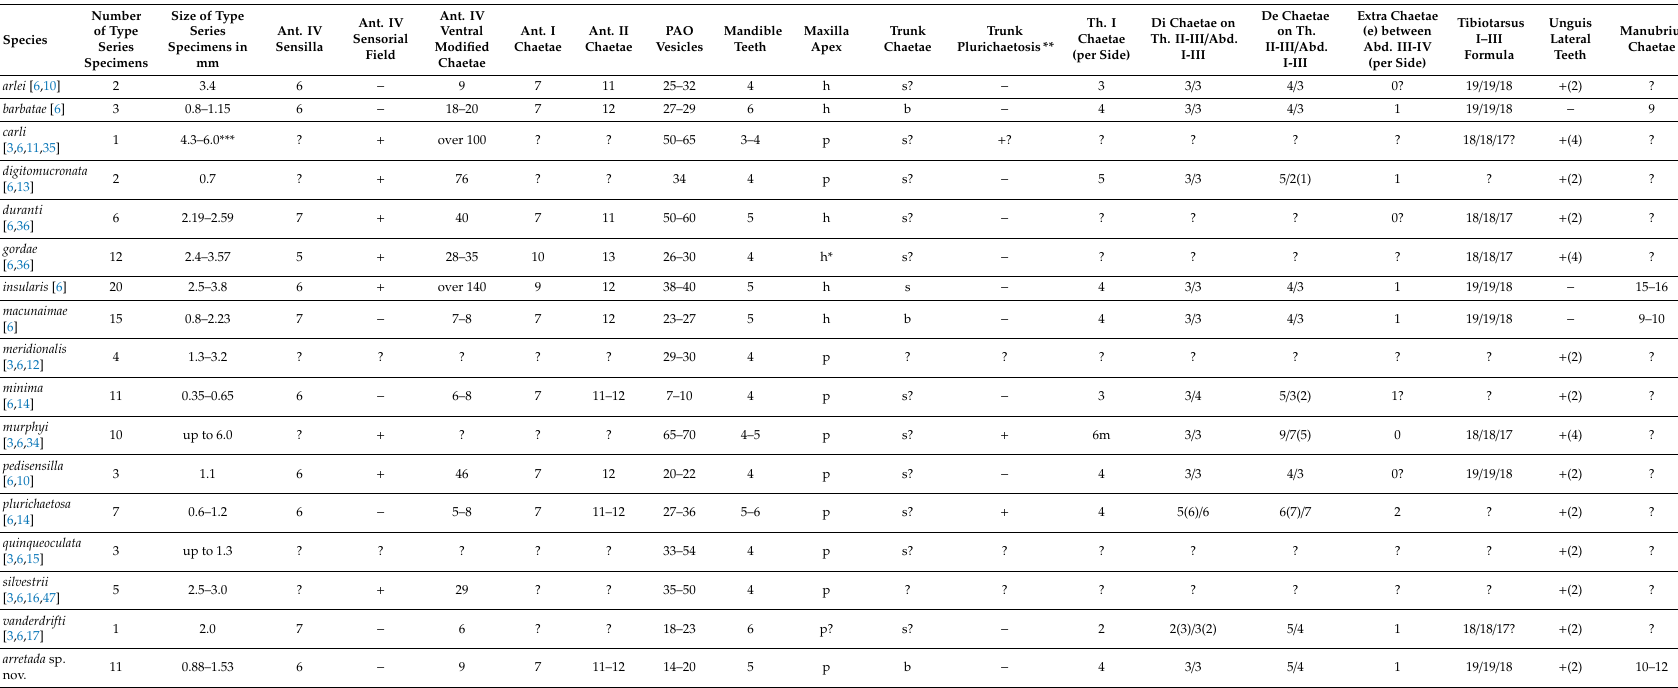
Table 1. Main features of Neotropiella Handschin, 1942